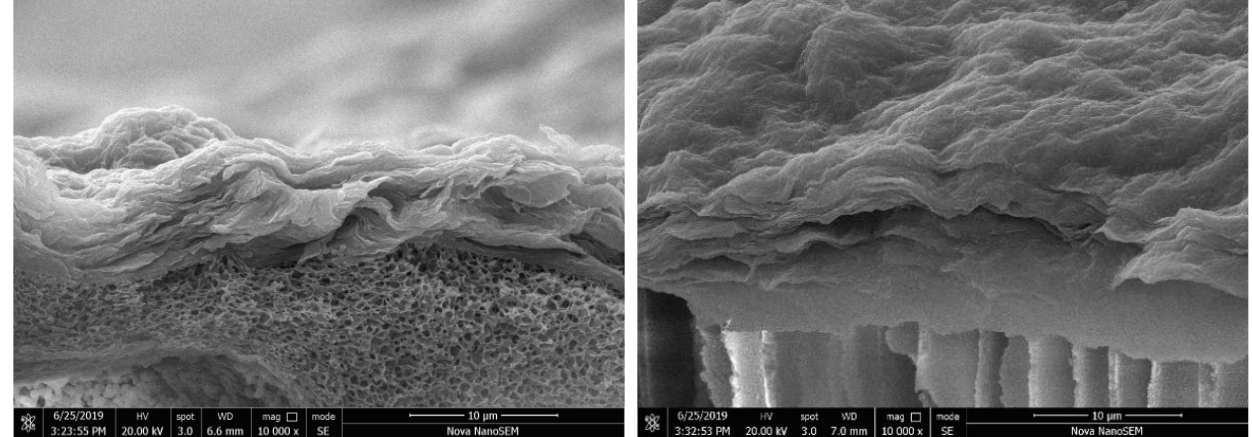
Figure 4. Cross-section morphology of P84/GO composite membranes ( left , without chitosan, right , with chitosan).